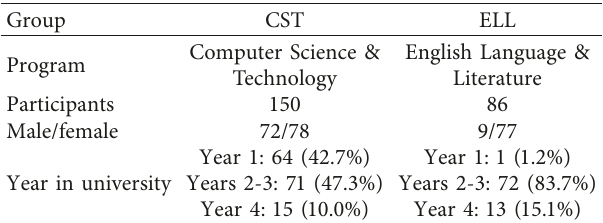
Table 1: Student sample